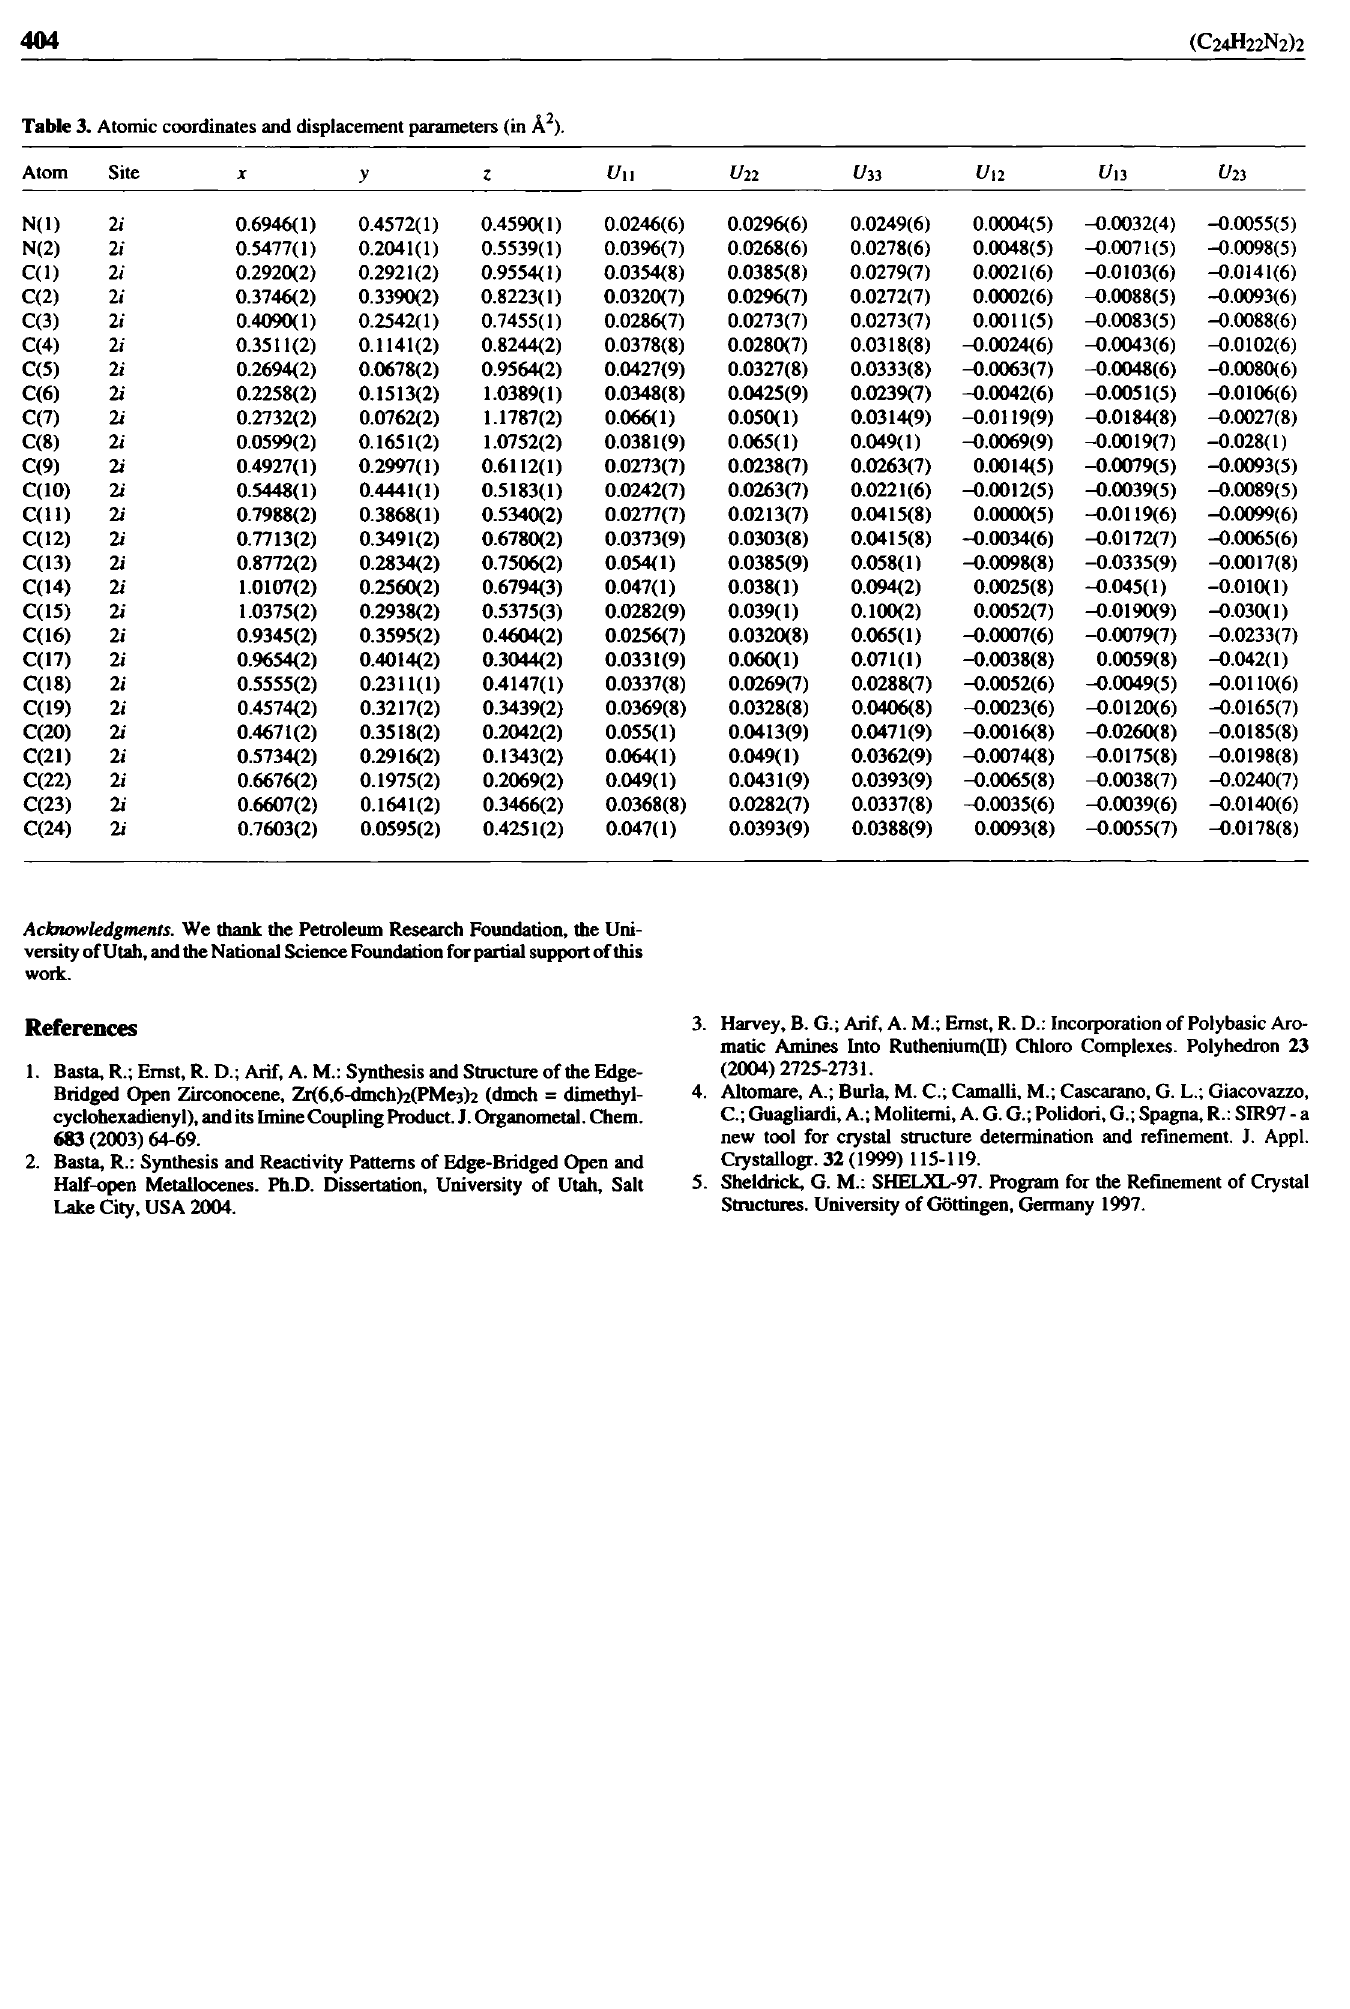
Table 3. Atomic coordinates and displacement parameters (in Â 2